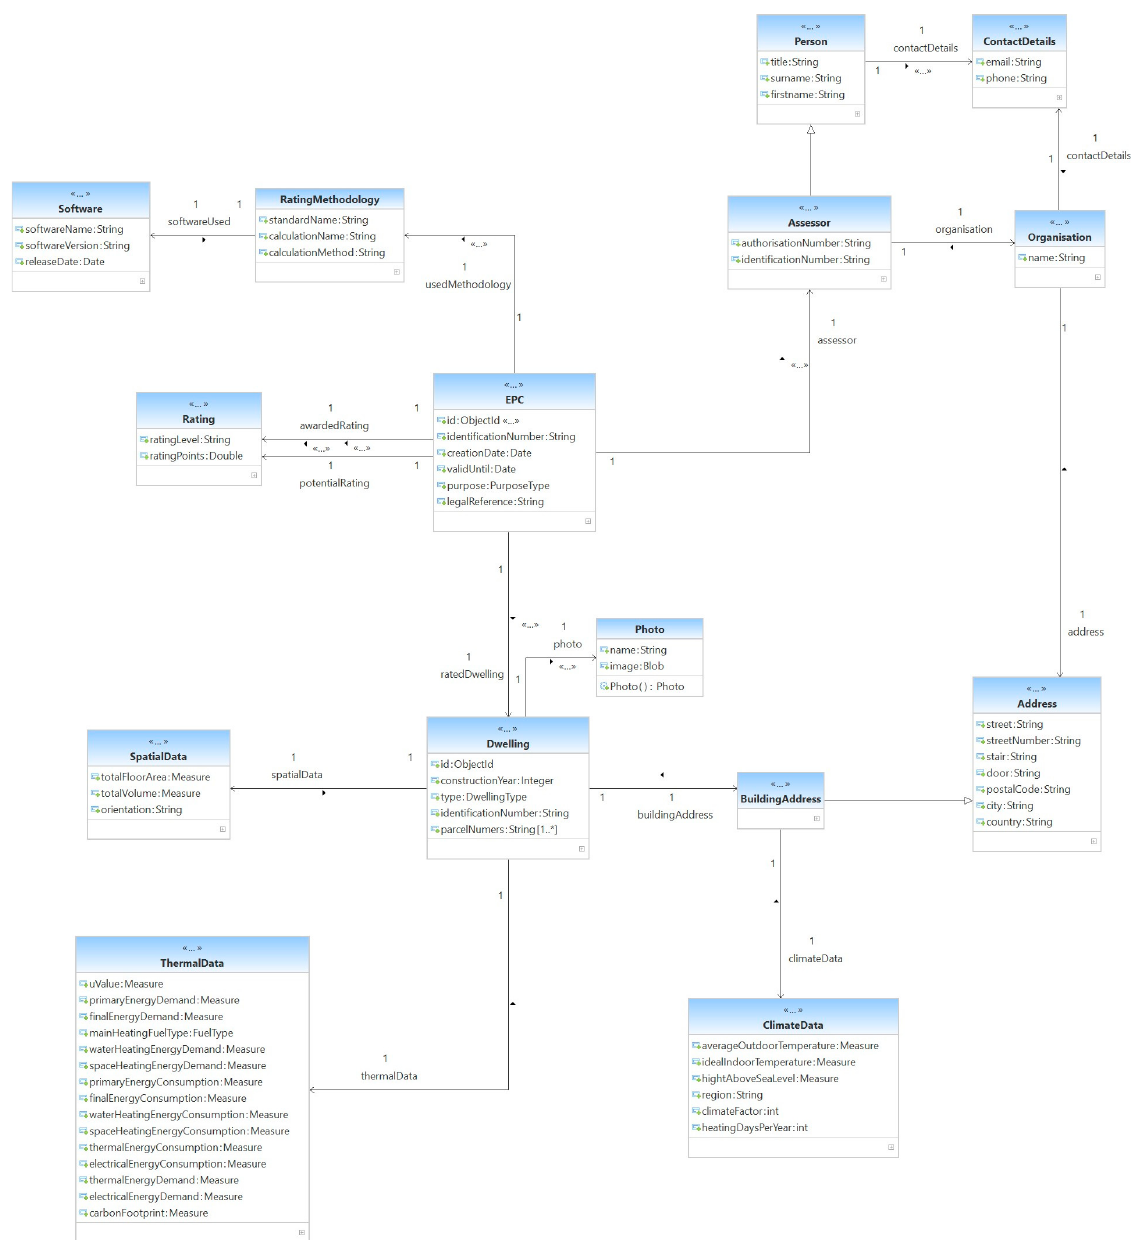
Figure 2. UML class diagram for EPCs.